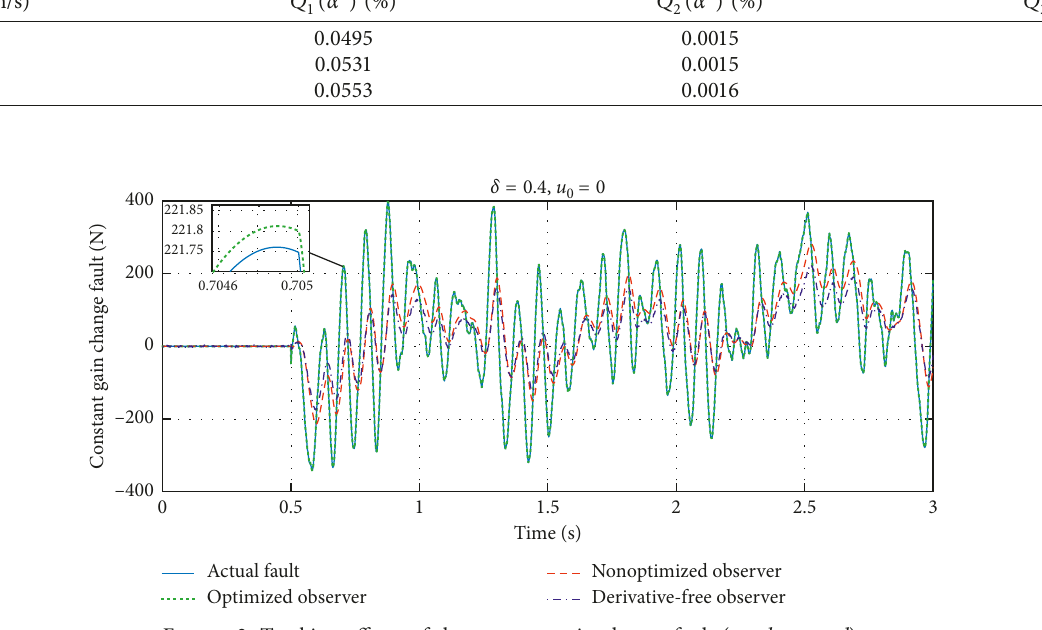
Figure 2: Tracking effects of the constant gain change fault ( random road ).